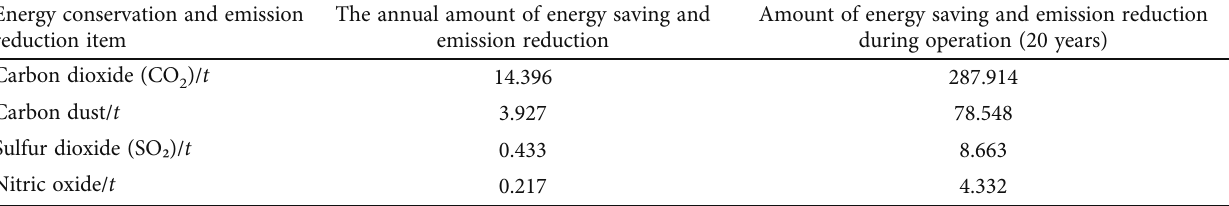
Figure 12: Detailed diagram of annual electricity Table 7: Table for the amount of energy saving and emission reduction.